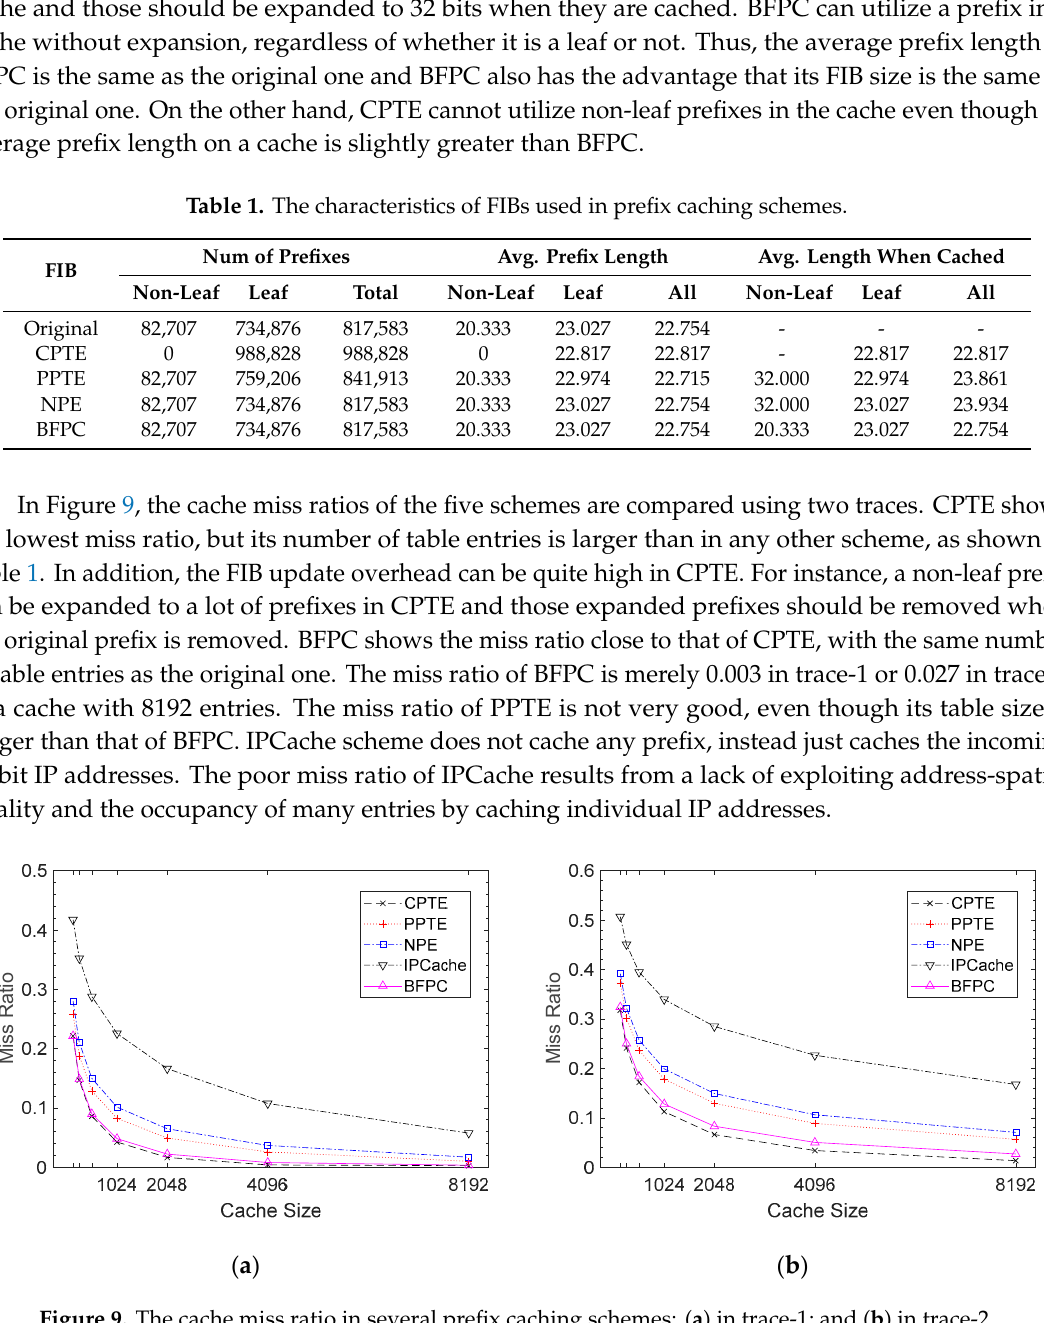
Figure 9. The cache miss ratio in several prefix caching schemes: ( a ) in trace-1; and ( b ) in trace-2.